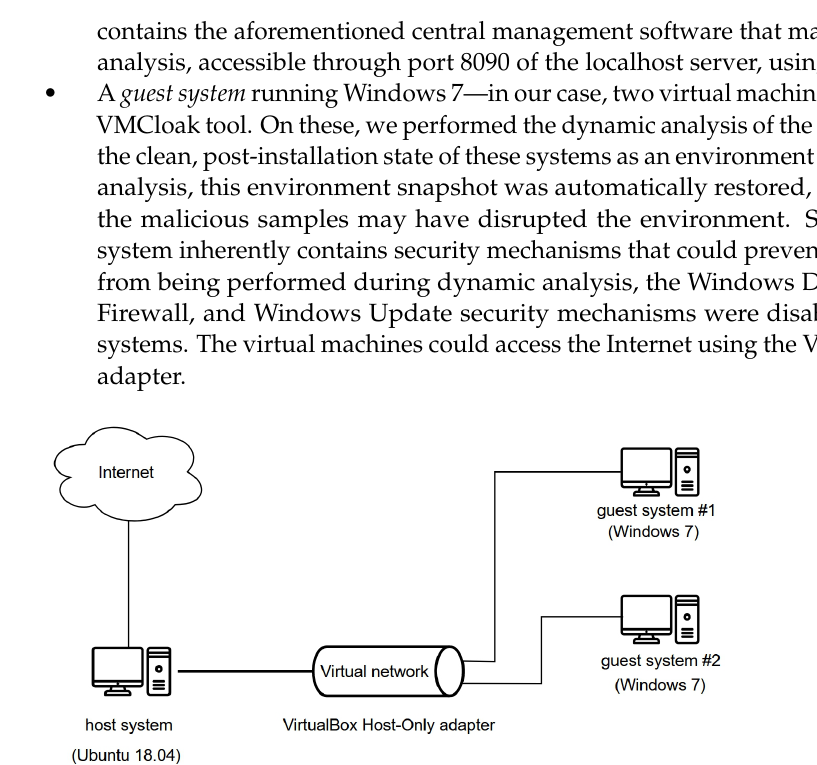
Figure 2. Architecture of the dynamic analysis